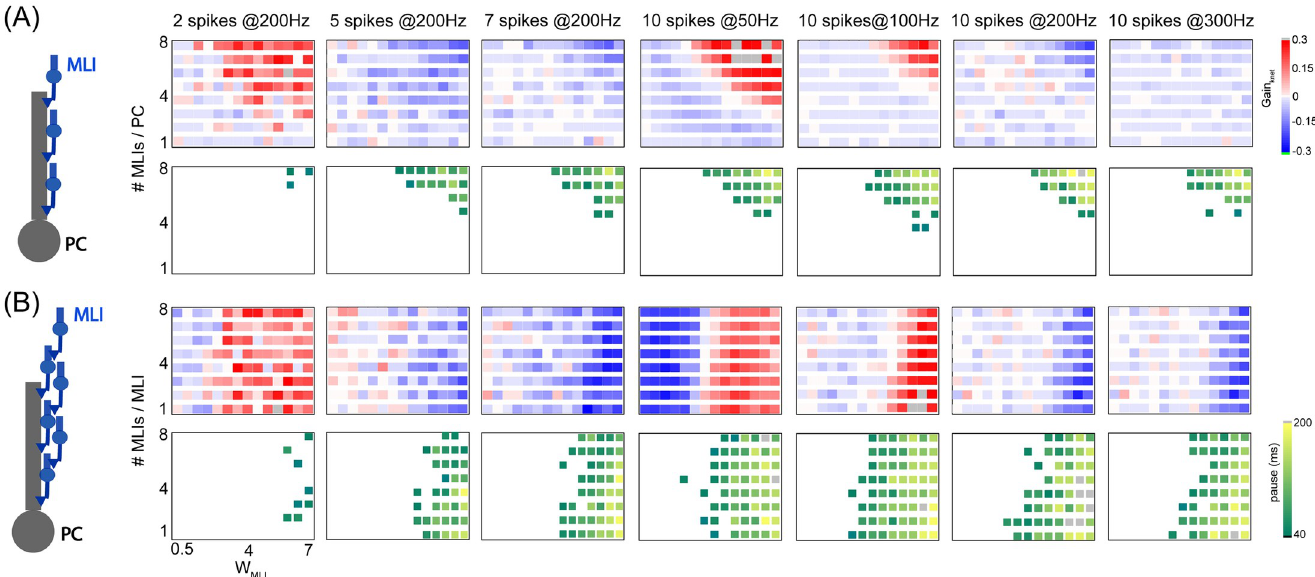
Fig 11. PC synchronization and pause response controlled by MLI inhibition. (A) PC network with no recurrent MLI inhibition. (Left) Illustration of the PC network receiving different numbers of MLIs. PC synchronization (top) and pause response (bottom) affected by MLI inhibition with stronger weight or more number of MLI-PC synaptic connections per PC, under burst inputs with different spikes and frequencies. Inner rectangles in each panel represent the gain of synchronization under one burst protocol. The gain of synchronization was defined as the relative change of the average K net . (B) Similar to (A) but for the PC network with recurrent MLIs included, such that each MLI receives 1-8 MLIs recurrently. Here in all plots, each PC receives 8